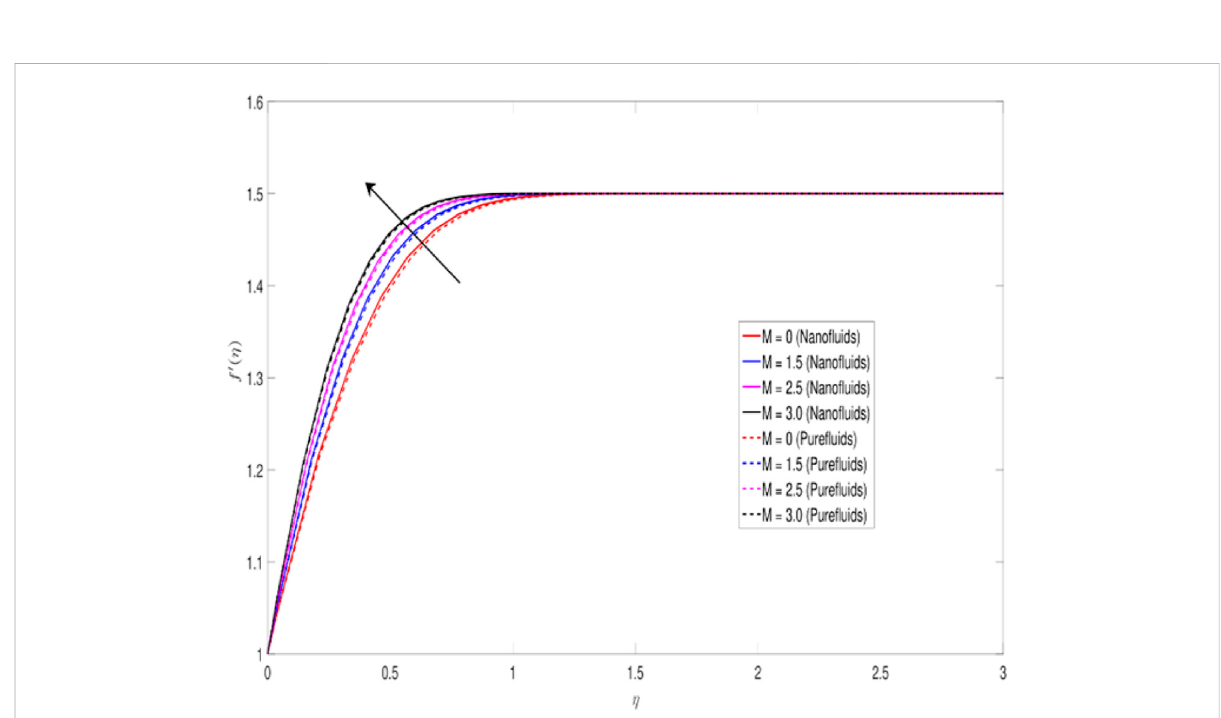
FIGURE 6 Velocity pro fi le in relation to magnetic fi eld